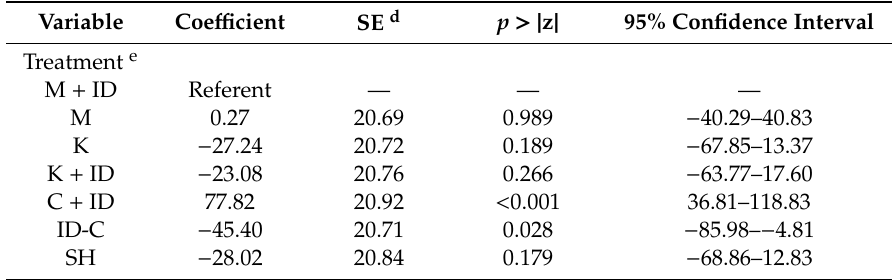
Table 4. Serum cortisol (nmol / L) 1-h post-castration by treatment group using meloxicam and iron dextran (M + ID) treatment group as the referent category, accounting for additional fixed a and random b e ff ects (model 3) c .